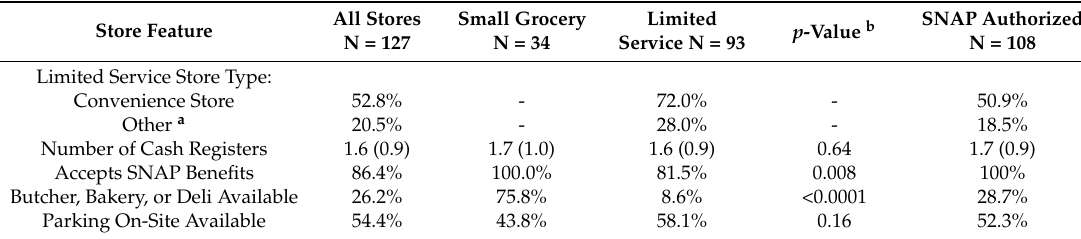
Table 1. Features of small food stores stratified by store type, % or mean